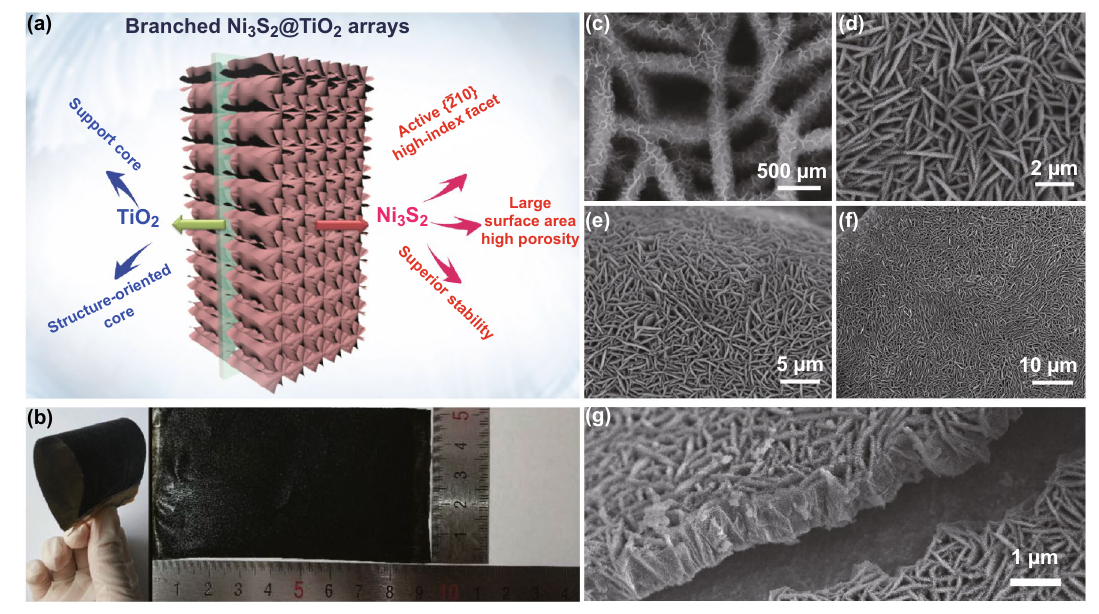
Fig. 1 a Schematic illustration of the core/branch structure of the TiO 2 @Ni 3 S 2 arrays. b Optical photograph of the sample. c – g SEM images of the TiO 2 @Ni 3 S 2 core/branch